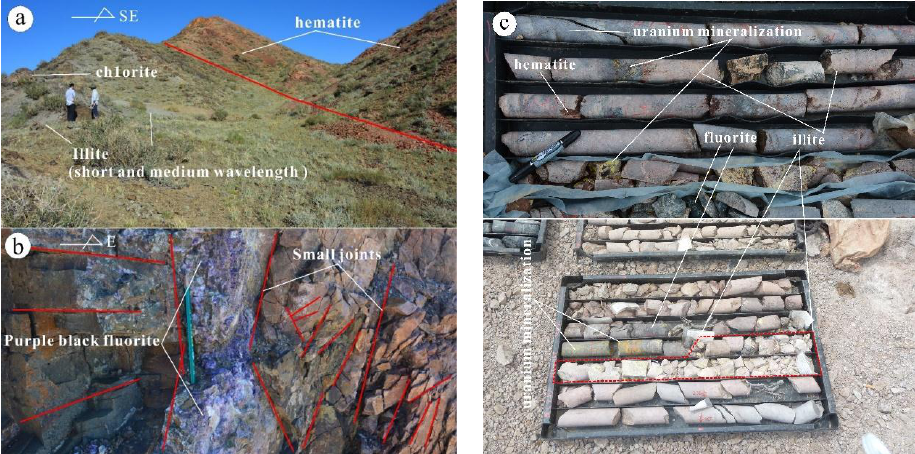
Figure 13. ( a ) Field photograph of alteration minerals, including illite (short-wavelength and medium-wavelength) and hematite. ( b ) Field photograph of purple-black fluorite in the Baiyanghe uranium deposit. ( c ) Picture of illite, fluorite, hematite and uranium mineralization in cores from the drill holes in the Baiyanghe uranium deposit.